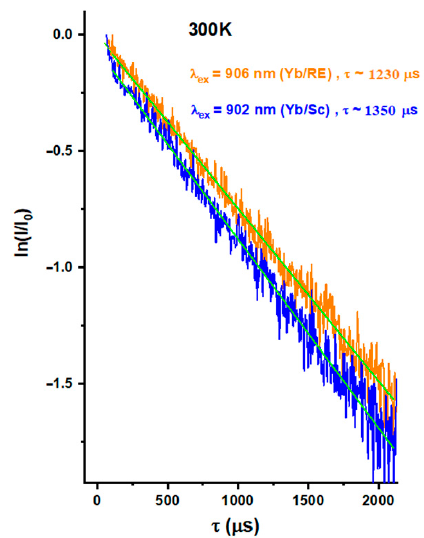
Figure 24. Emission spectra of LYSB:Yb (4 at.%) crystal under selective excitation in σ -polarization ( a ) and π -polarization ( b ) at 10 K. Adapted with permission from ref. [44], copyright 2020, Elsevier.